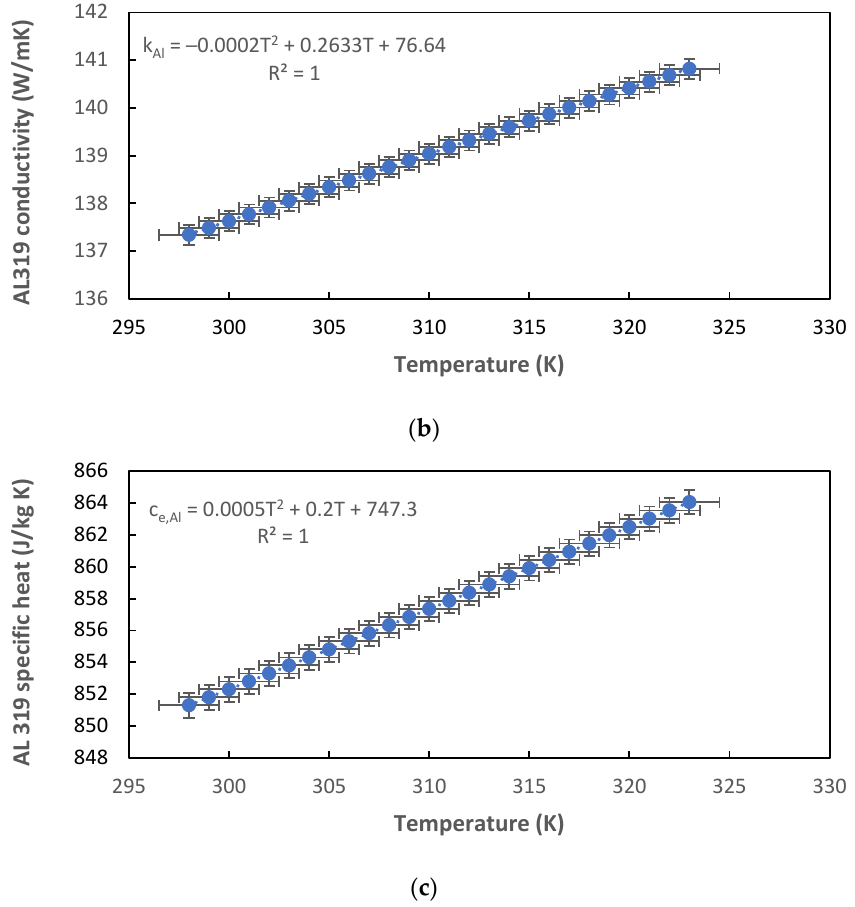
Figure 4. Al 319 relation between material properties and temperature. ( a ) Density, ( b ) Thermal conductivity, and ( c ) Speci fi c heat.